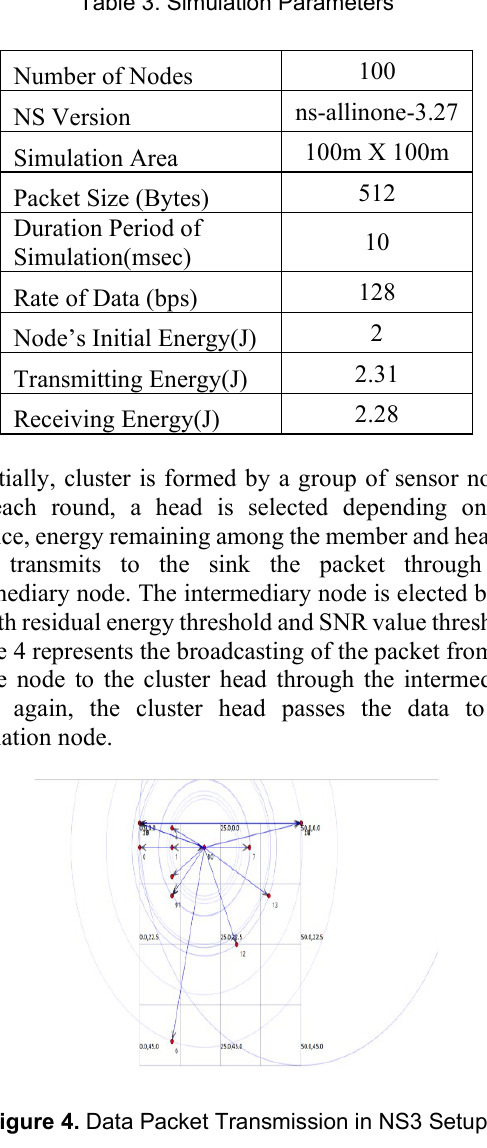
Table 3. Simulation Parameters